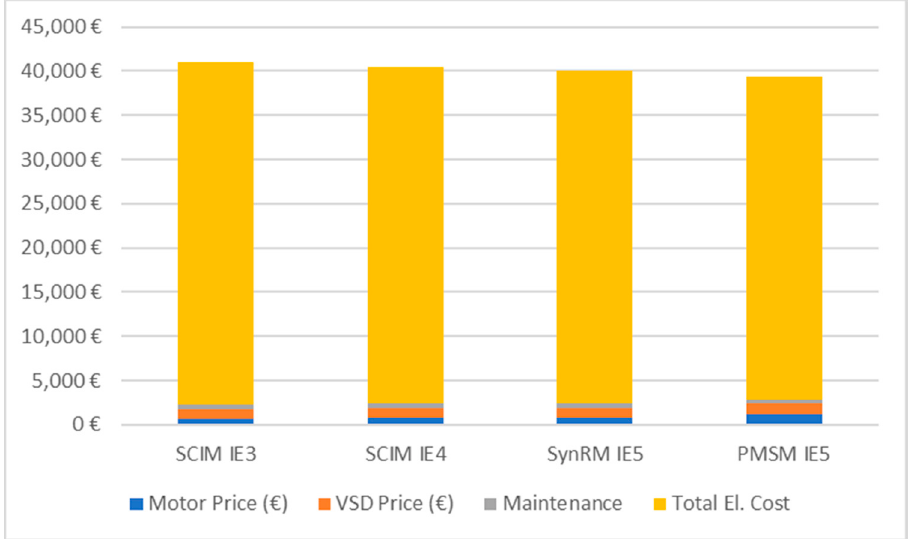
ff erent motor technologies and Figure 11. Disaggregated TCO for the different motor technologies and LP2. Figure 11. Disaggregated TCO for the di Figure 11. Disaggregated TCO for the different motor technologies and LP2.